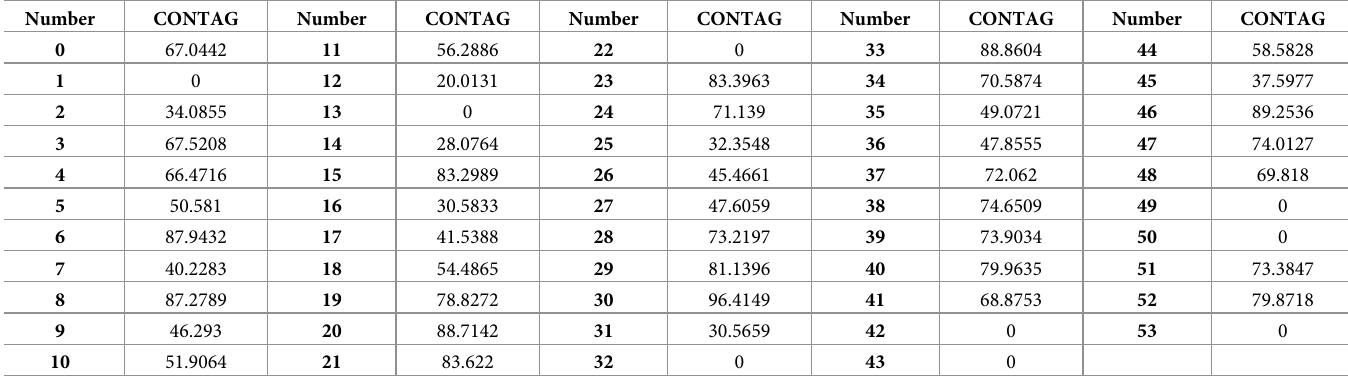
Table 6. CONTAG values of individual study units.